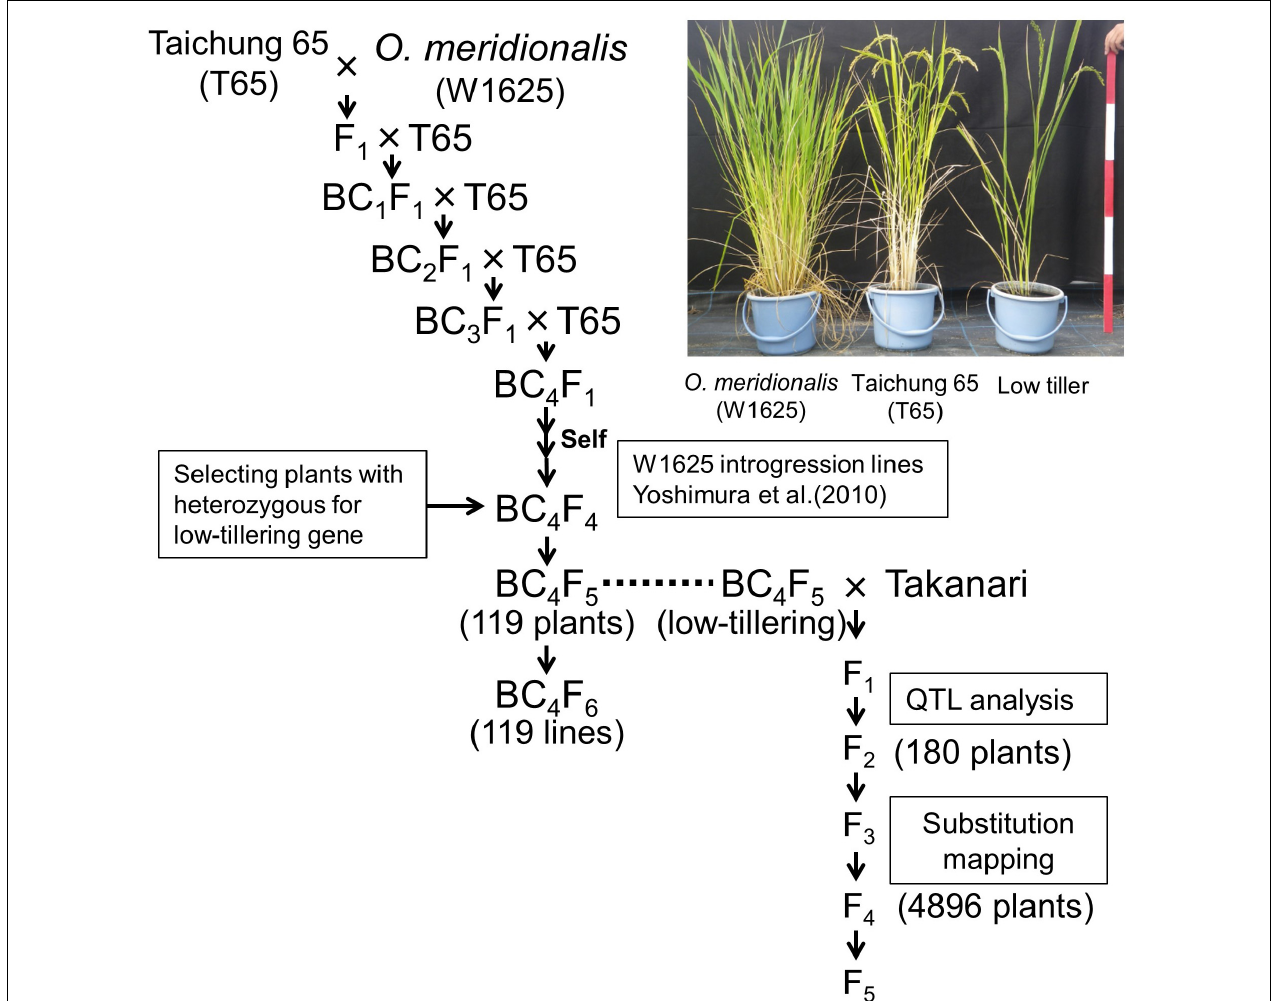
FIGURE 1 | Breeding scheme for developing lines with low-tillering. The BC 4 F 5 and BC 4 F 6 populations were derived from a cross between “Taichung 65” (T65) and O. meridionalis . The F 2 population was derived from a cross between low-tillering BC 4 F 5 plants and